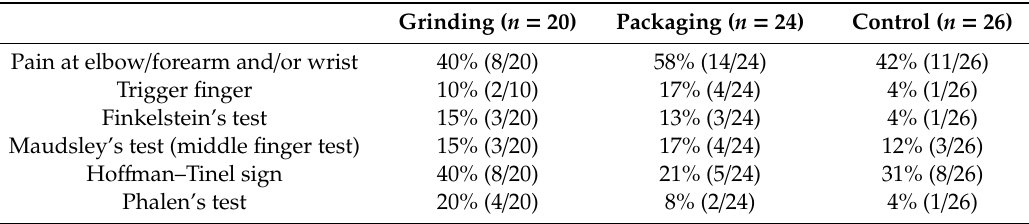
Table 7. Clinical data: prevalence of pathognomonic clinical signs.